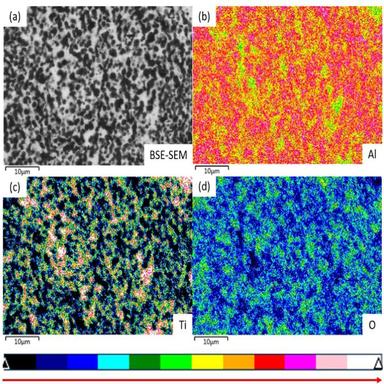
EDS concentration mapping with BSE-SEM image showing the distributions of selected elements. The concentration of the elements is ordered based on the color sequence in the visible light spectrum with a color bar shown below the maps. (a) FESEM image showing the phase distribution, where the black regions correspond to the alumina phase and the white regions correspond to the titanium aluminide phase; (b) Distribution and concentration of Al in the FESEM image; (c) Distribution and concentration of Ti in th